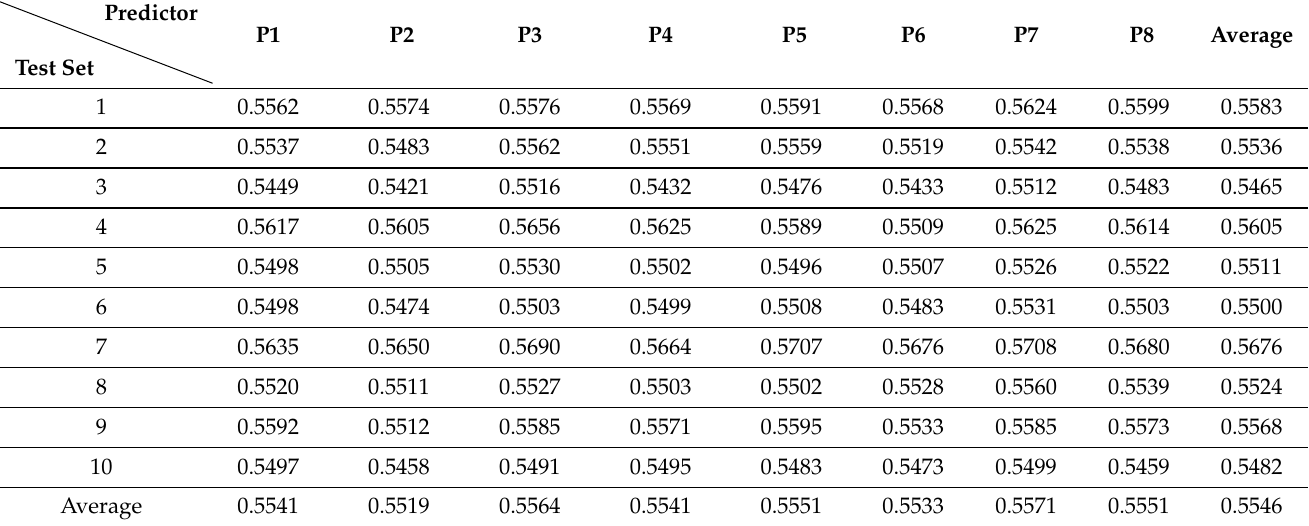
Table 8. Experiments with model ensemble.